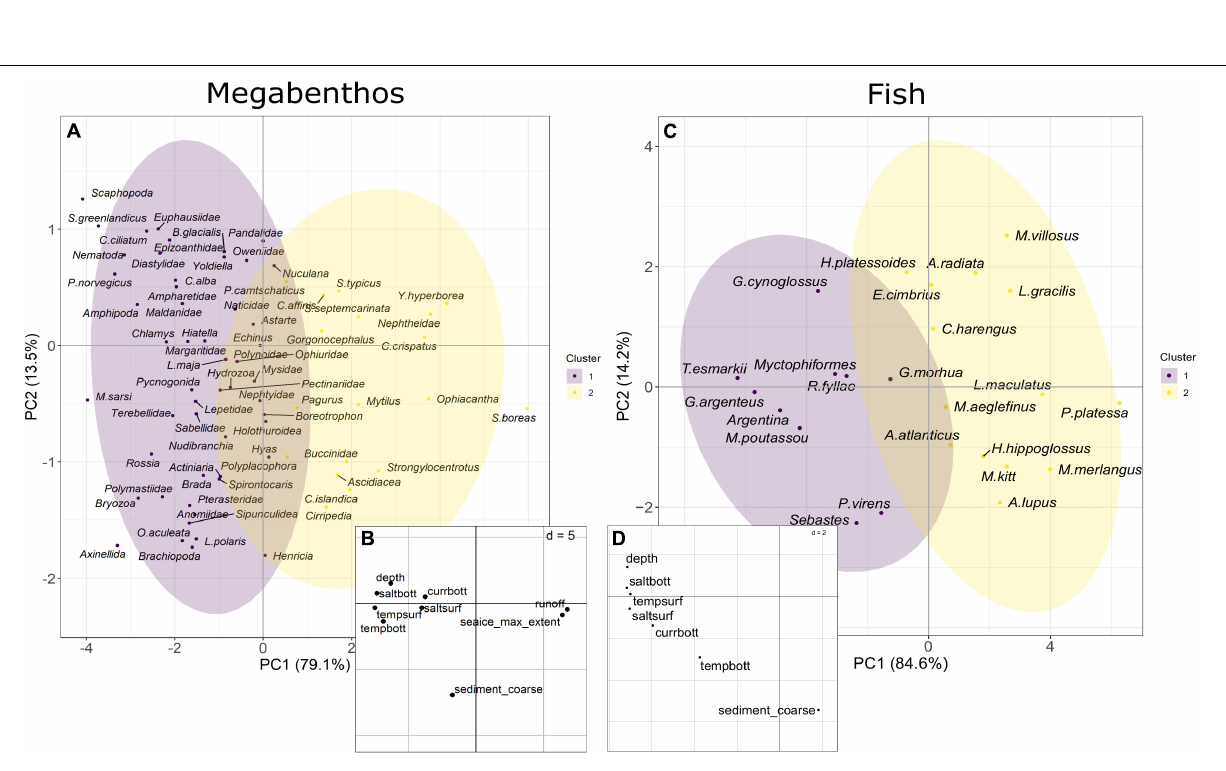
Frontiers in Marine Science |